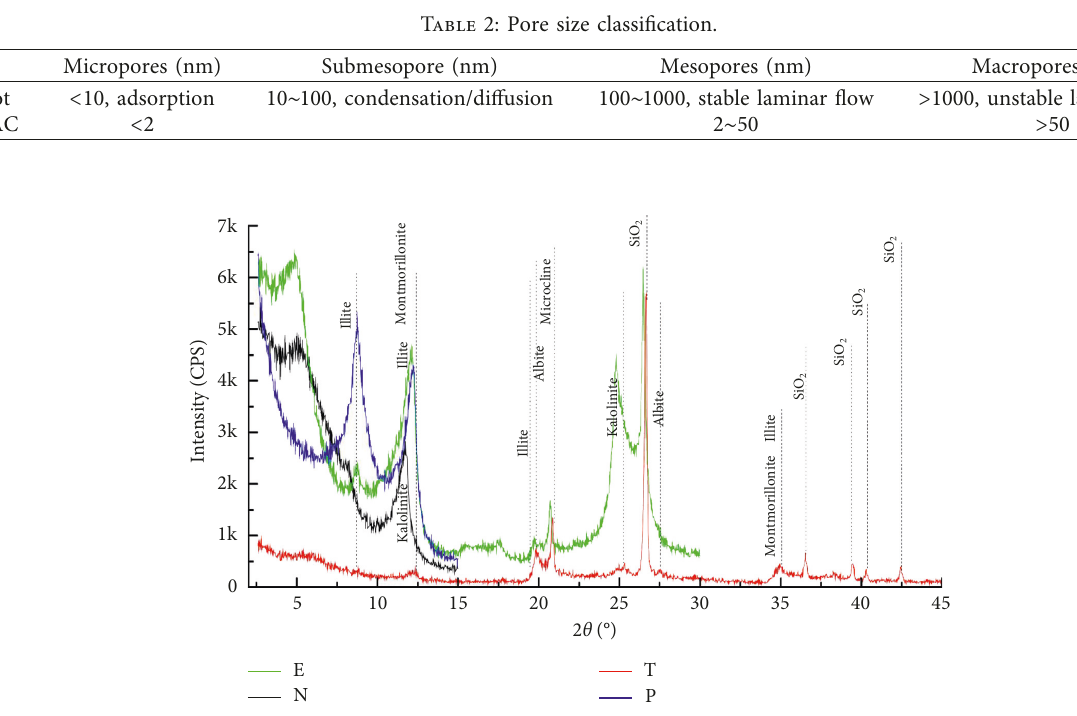
Figure 1: XRD spectrum of weakly cemented mudstone.